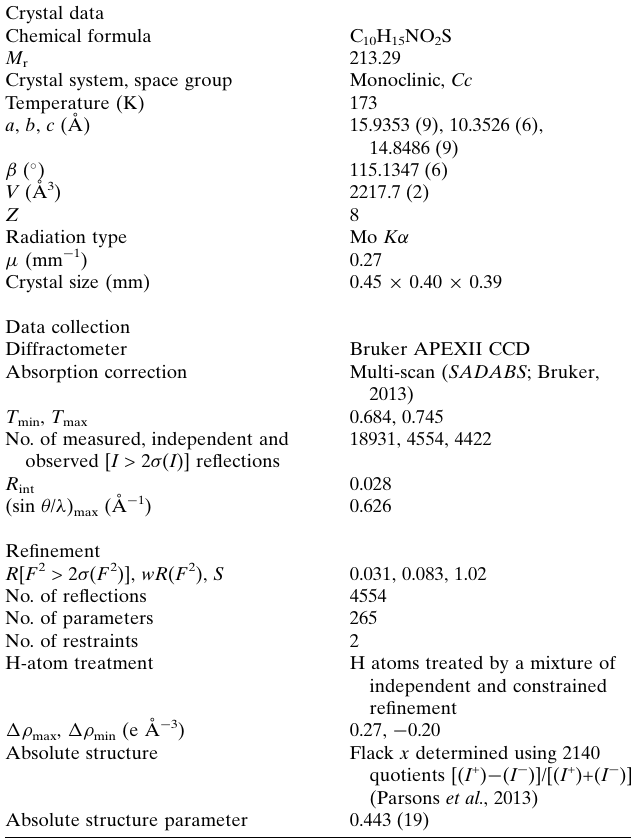
Crystal data Chemical